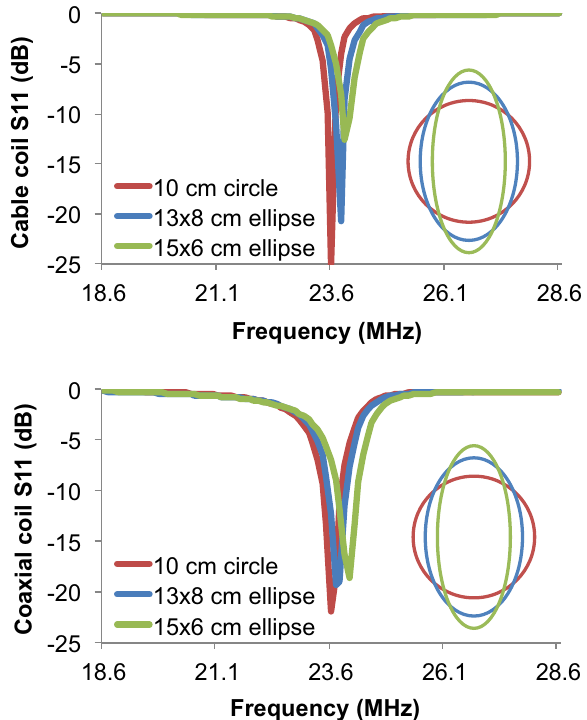
Figure 3. Reflection coefficient (S 11 ) as a function of geometry for a cable coil (top) and coaxial coil (bottom). The loops were tuned with circular geometry and wrapped onto a 13.5-cm cylindrical dielectric phantom. The loops were then elongated into ellipses with major (minor) axes of 13-cm (8-cm) and 15-cm (6-cm) without retuning. Scaled representations of the coil contours are overlaid.